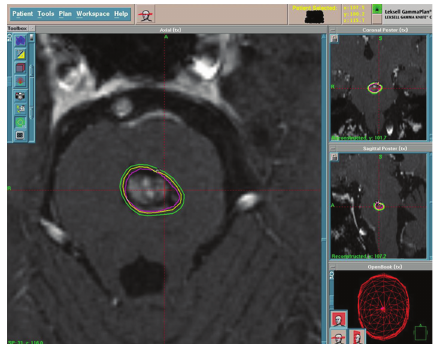
Figure 2: Axial T1 postgadolinium enhanced treatment planning brain MRI illustrating the targeting ability and radiation isodose lines of Gamma Knife radiosurgery for the pontine metastasis.